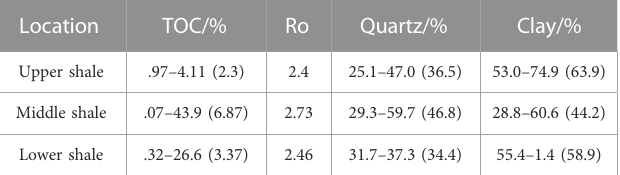
TABLE 1 Shale organic geochemical and main mineral composition characteristics.